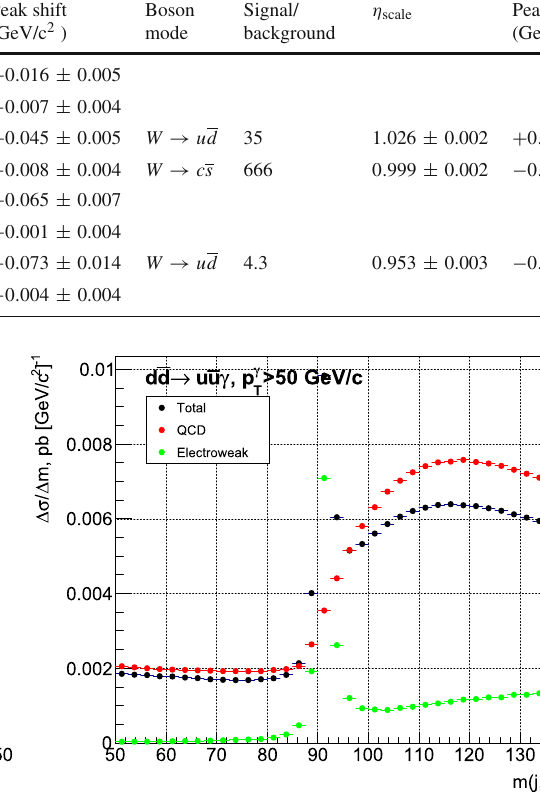
troweak t -channel component is much more prominent when t -channel W exchange is possible, but in each case the destructive interference is